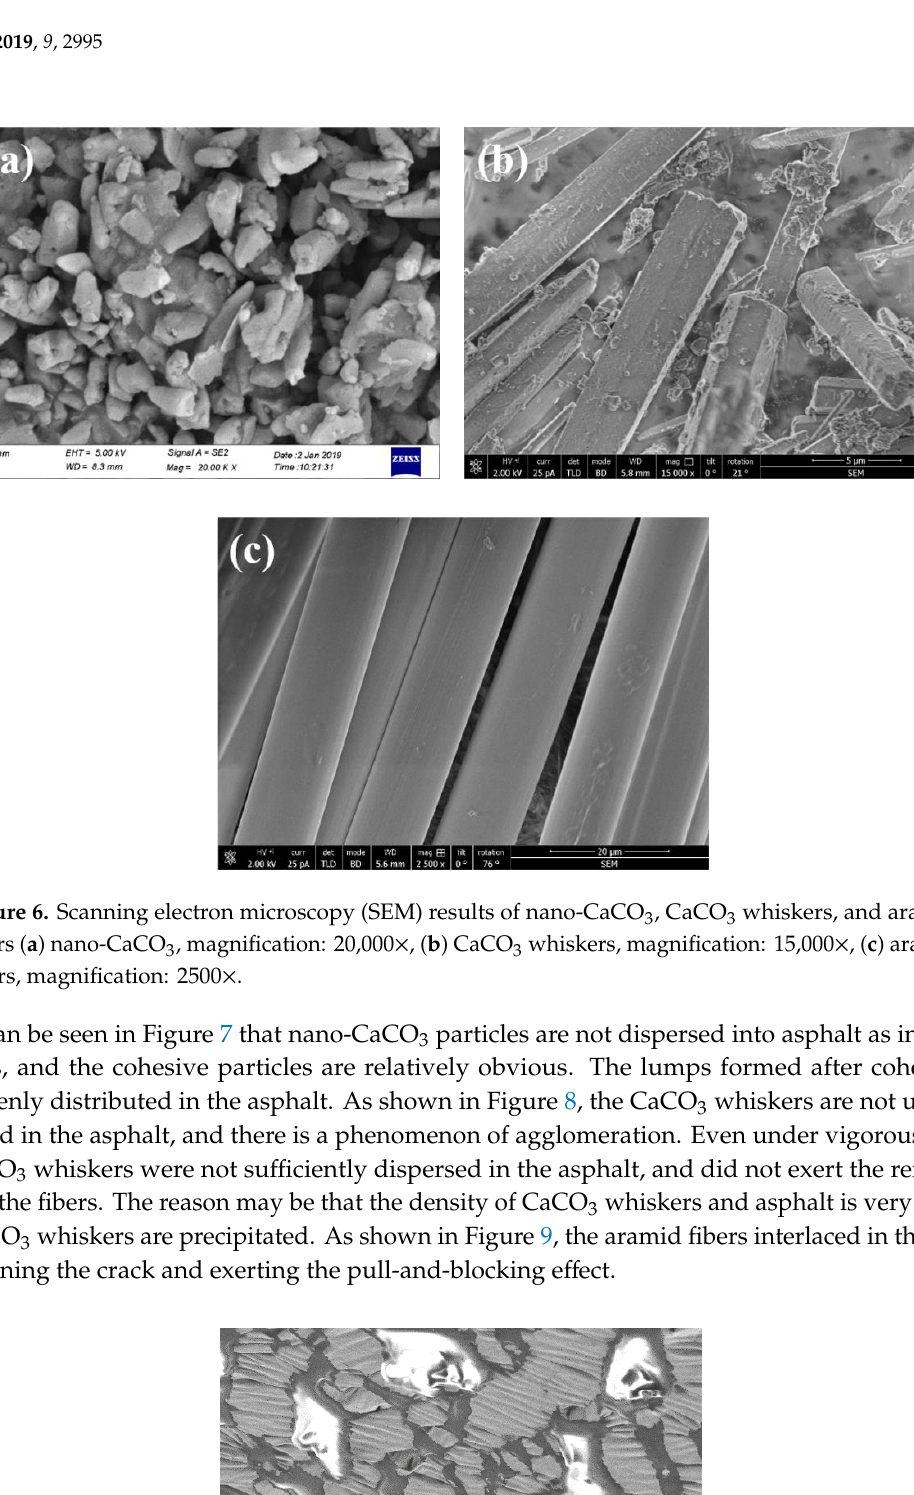
Figure 7. SEM result of nano-CaCO 3 -modified asphalt (magnification: 1000×).